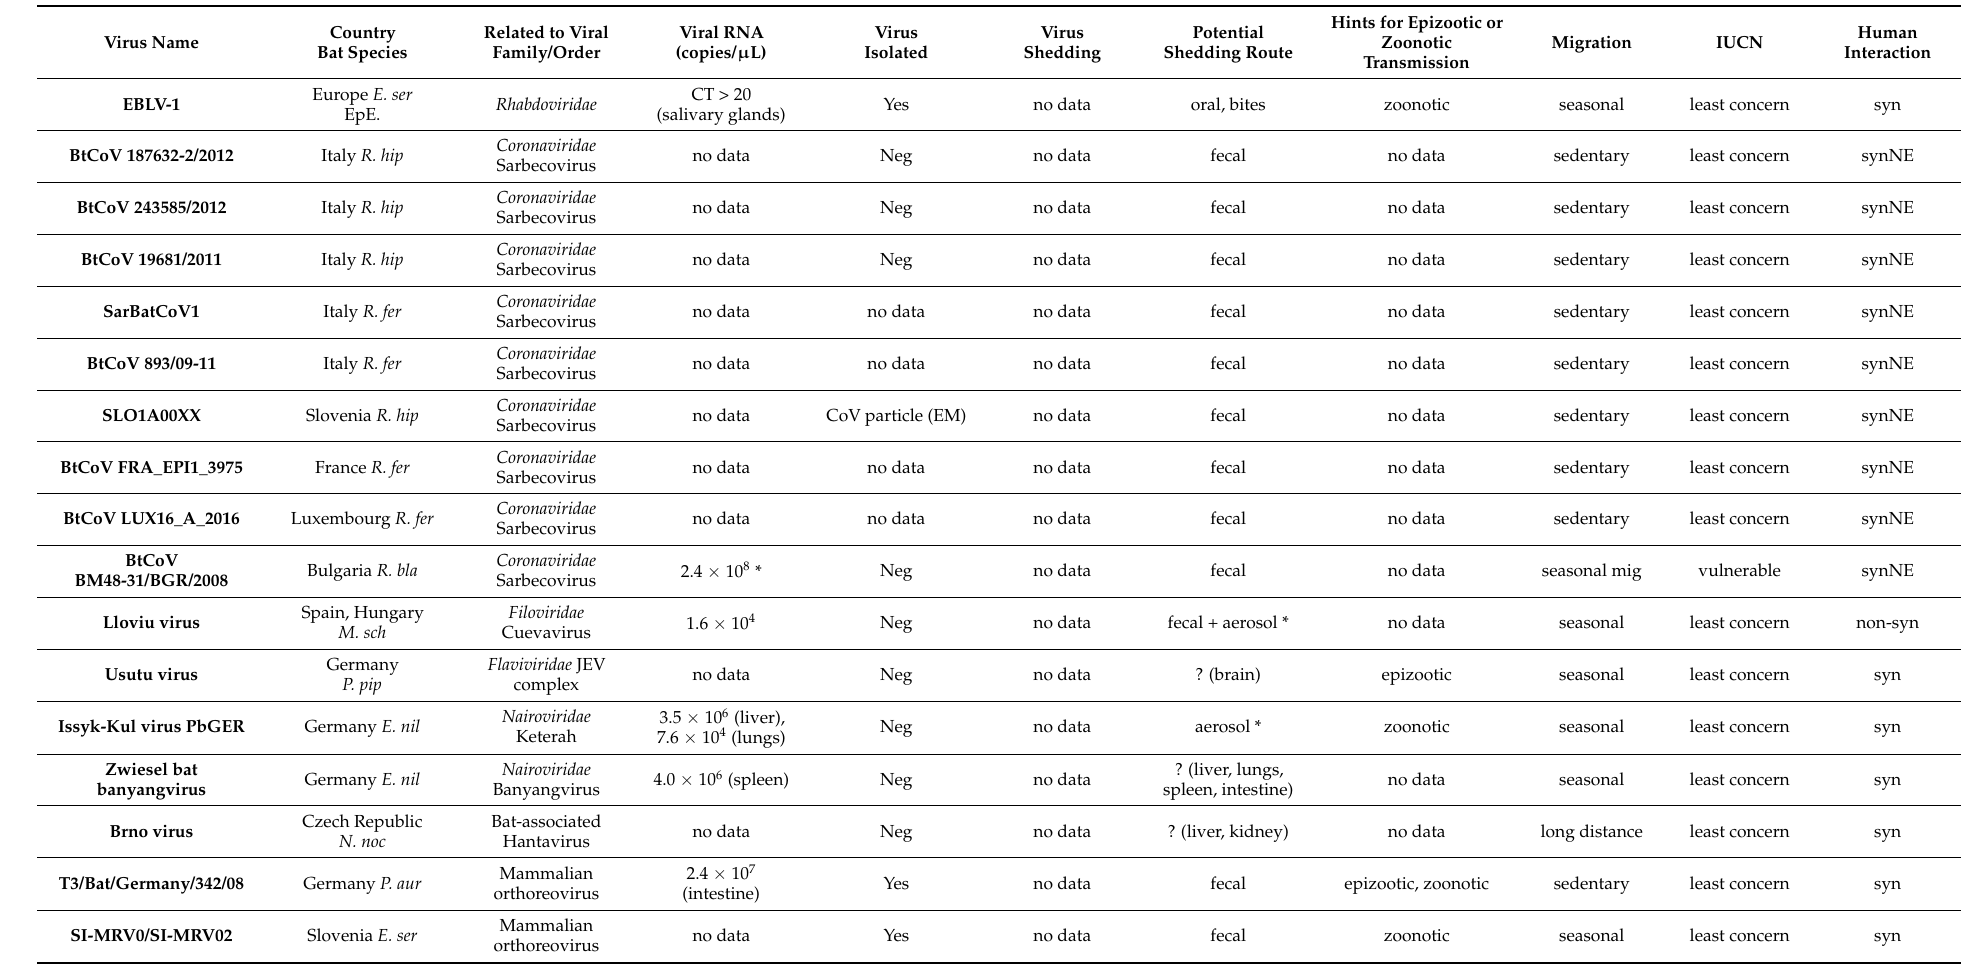
Table 4. Overview on risk factors that may contribute to zoonotic transmission and spillover. Bat species: E. Ser, Eptesicus serotinus; R. hip, Rhinolophus hipposideros; R. fer, Rhinolophus ferrumequinum; R. bla, Rhinolophus blasii; M. sch, Miniopterous schreibersii; P. pip, Pipistrellus pipistrellus; E. nil, Eptesicus nilssonii; N. noc, Nyctalus noctula; P. aur, Plecotus auritus. Migration: seasonal; seasonal migrants; long distance; long-distance migrants. Human interaction: syn, synanthropic species; synNE, synanthropic in northern Europe; non-syn, non-synanthropic. * copies per gram of